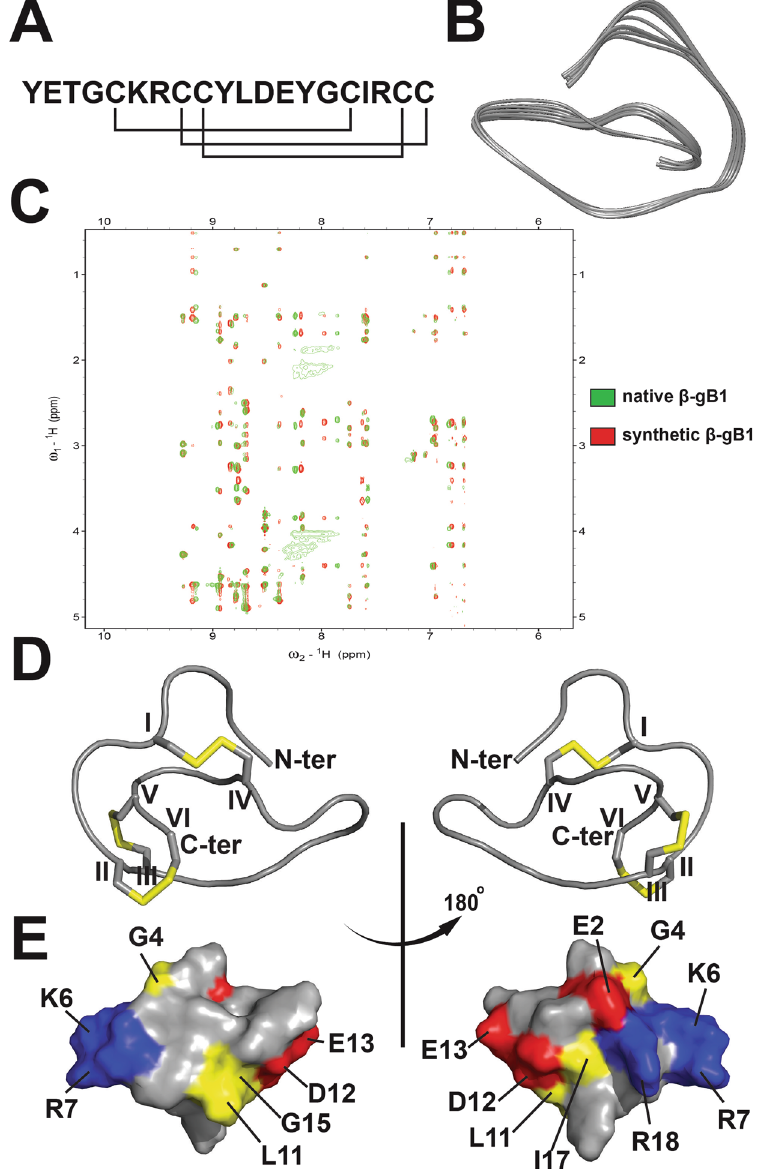
Figure 4. NMR spectra and structures of β -gB1 (PDB: 5XIV). ( A ) Sequence and disulfide connectivity of β -gB1. ( B ) The 20 lowest energies ensembles of β -gB1. ( C ) Overlapped 2D NOESY spectra of native (green) and synthetic β -gB1 (red) displayed by Sparky 3.115. ( D ) The ribbon representation of the synthetic β -gB1 structure. The disulfide bonds are formed between CysI–CysIV, CysII–CysVI, CysIII–CysV. ( E ) Surface topology of the synthetic bL1 structure. The distribution of electrostatic charges was illustrated in red (negatively charged), blue (positively charged) and yellow (hydrophobic). The positively charged surface (K6, R7 and R18) was opposed to the negatively charged surface (E2, D12 and